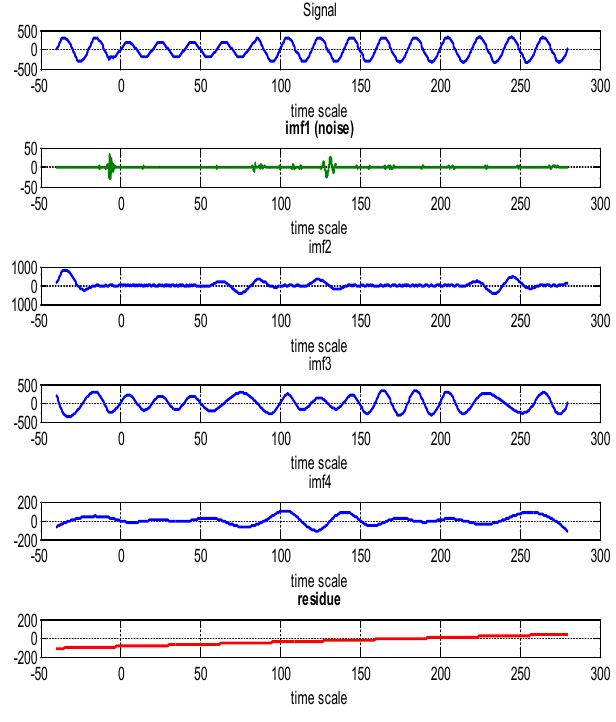
Fig. 5. IMFs for a voltage sag signal processed with